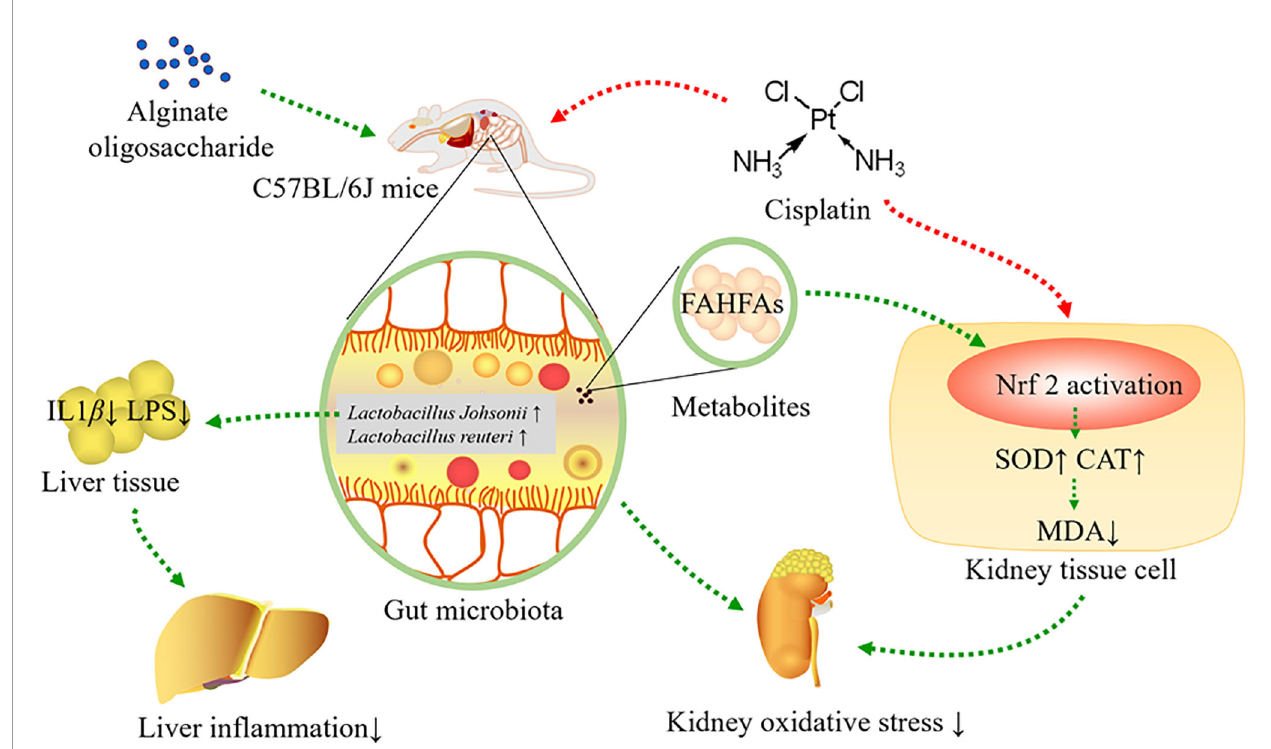
FIGURE 8 | Alginate oligosaccharide alleviated cisplatin-induced kidney oxidative stress via Lactobacillus genus-FAHFAs-Nrf2 axis in